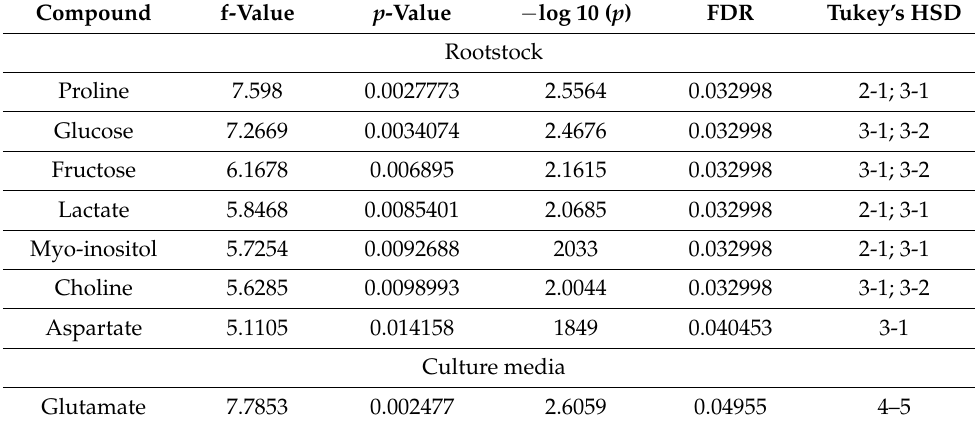
Figure 1. Important features selected by ANOVA plot with p -value threshold 0.05 for lemon peel cultivated under 9 different treatments (3 rootstocks × 3 substrates), highlighting ( A ) differences based on the substrate employed and ( B ) differences based on the rootstock. Table 3. Important features identified by one-way ANOVA and post hoc analysis for the lemon peel related to the rootstock and the culture medium used, where 1 to 3 corresponds to the rootstock type as (1) Citrus macrophylla ; (2) Citrus aurantium ; and (3) Citrus aurantium/Citrus sinensis ; and 4 to 5 is related to the culture media: (4) 50% peat + 50% port sediment; and (5) 75% peat + 25% port sediment.